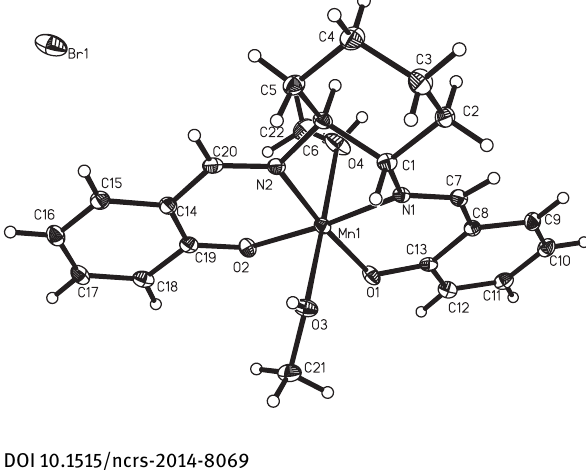
Table 1: Data collection and handling.